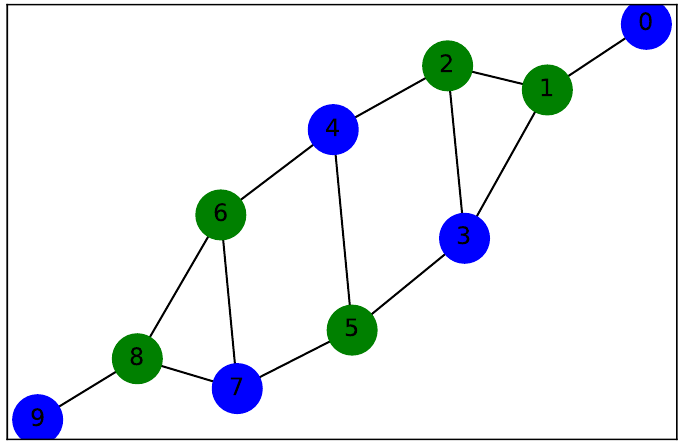
Figure 7. Value stream network clustering with